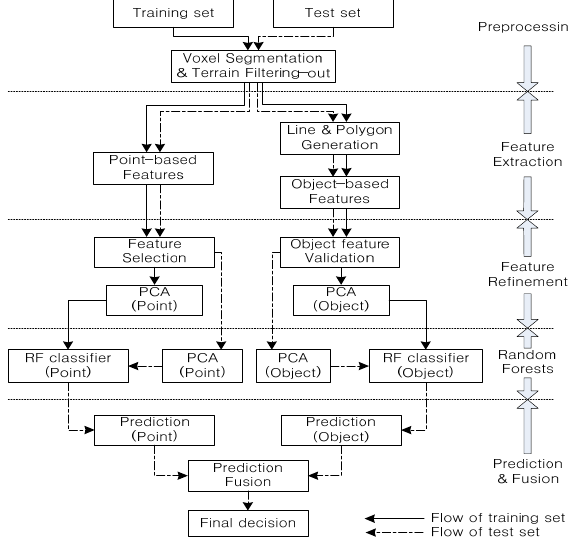
Figure 3. Flow chart of Random Forest based MCS classification for training and